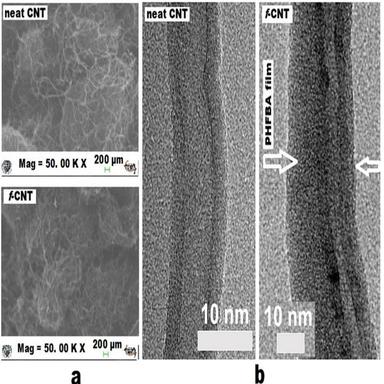
a) SEM images of neat and f-CNTs; b) TEM images of neat and f-CNTs.